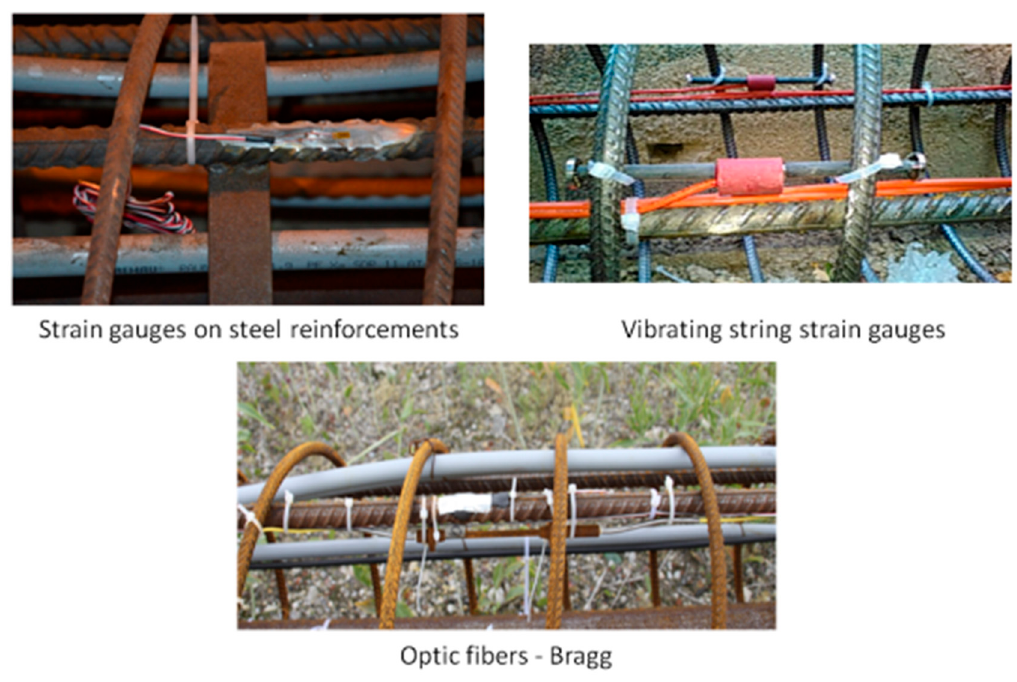
Figure 9. Example of strain measurements.